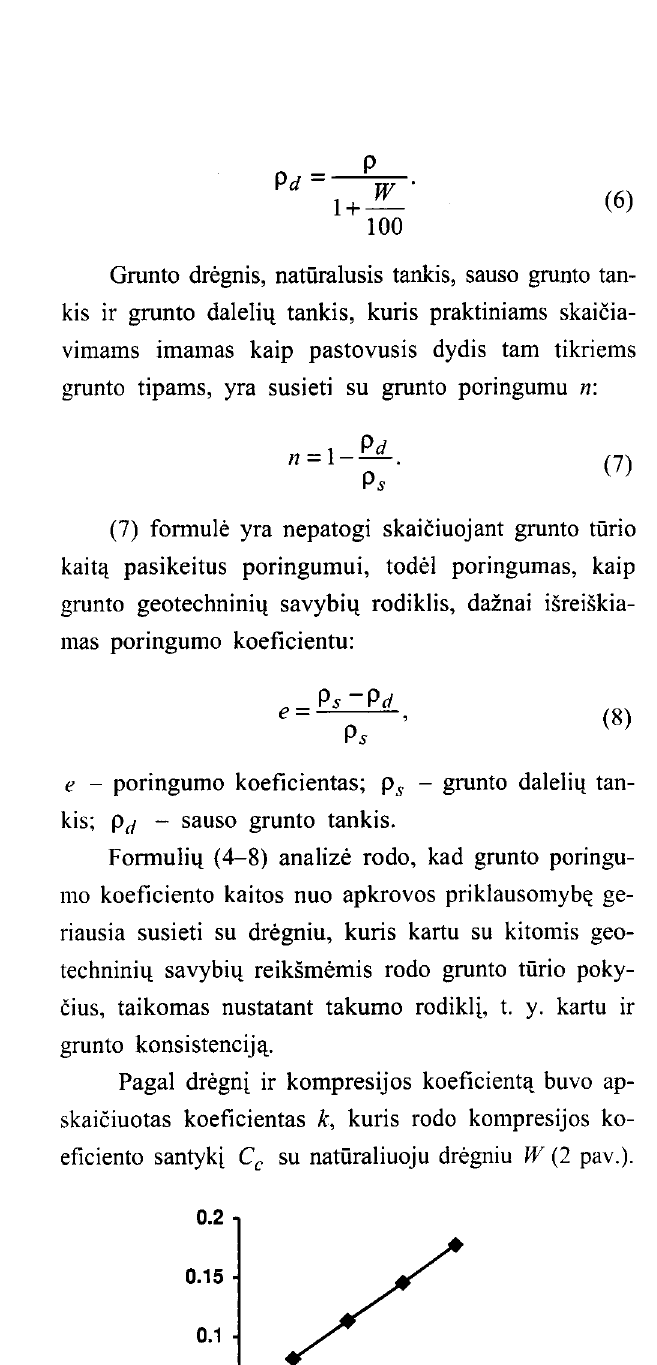
Fig 2. Dependence of the coefficient of compressibility C c upon natural humidity W